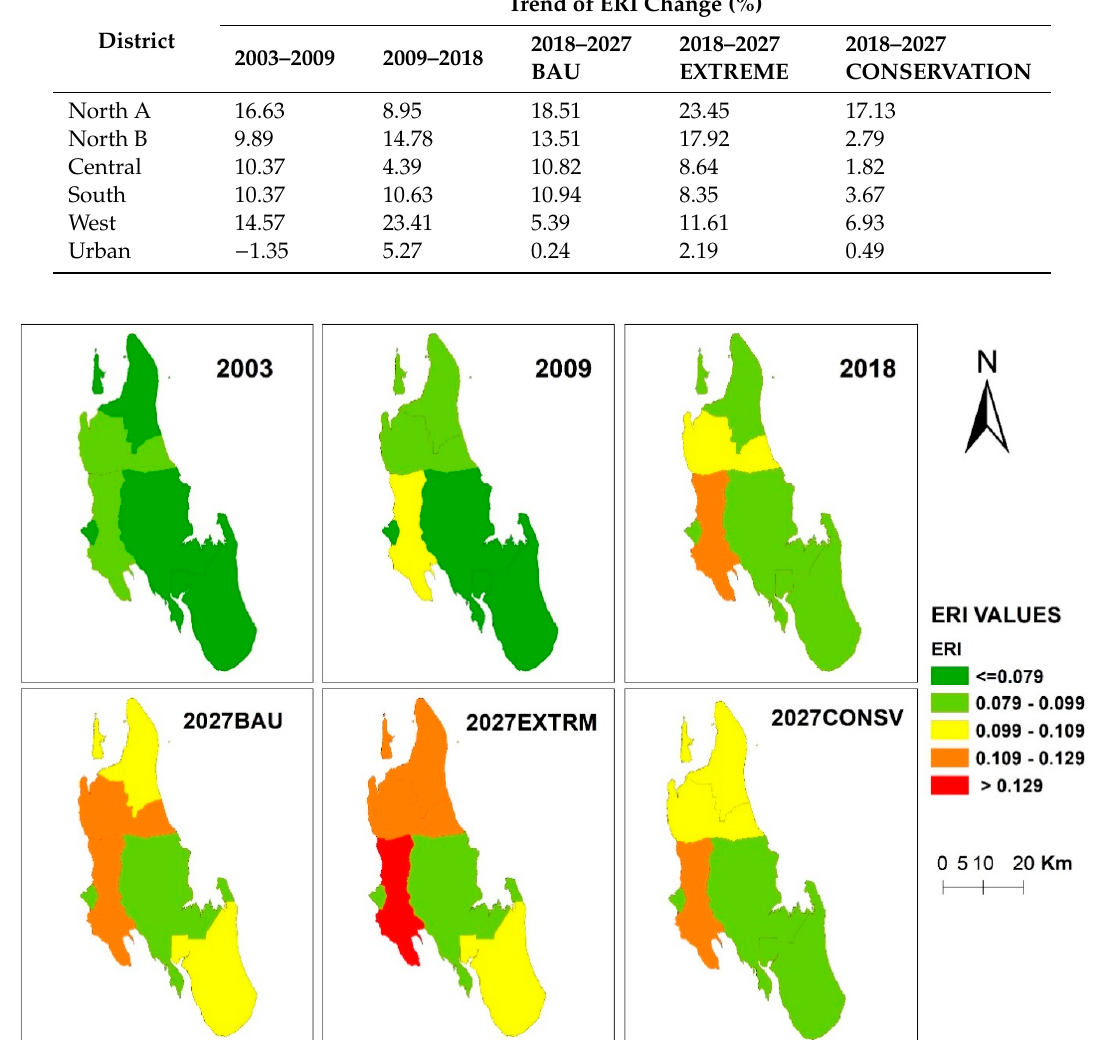
Figure 11. Trend of Ecological Risk Index (ERI) per district 2003–2027 (EXTRM: Extreme; BAU: Business as usual; CONSV: Conservation).